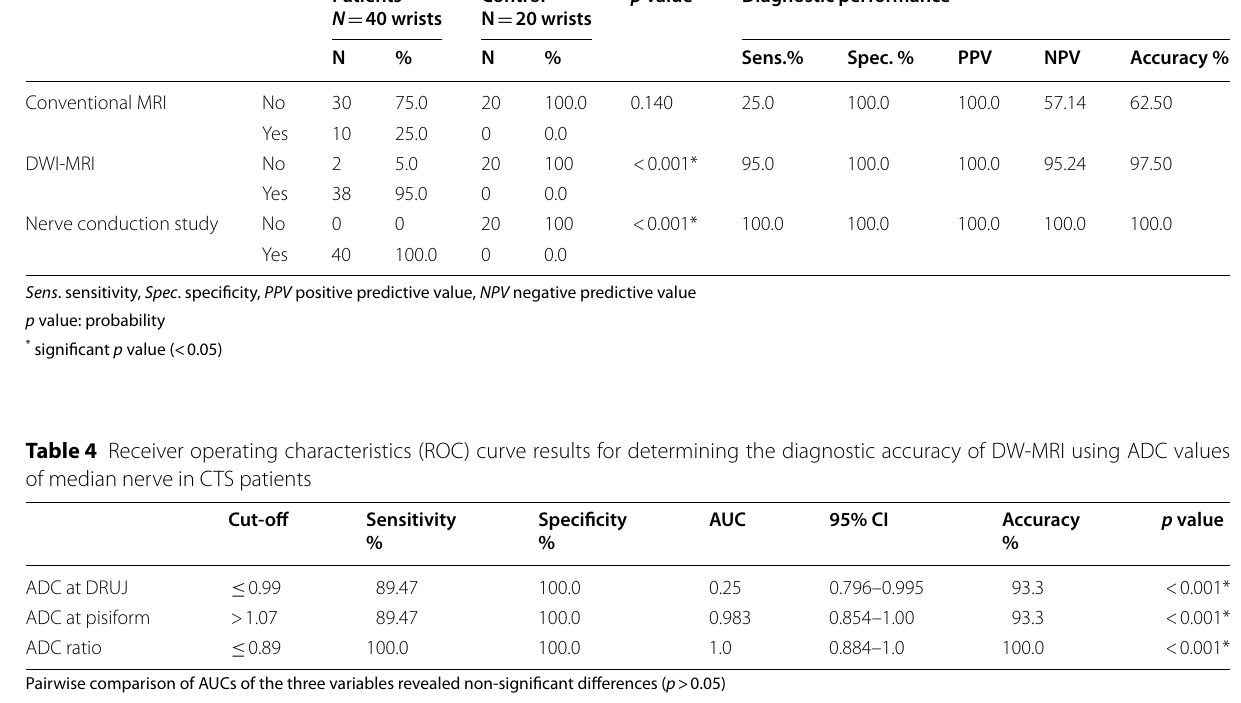
Pairwise comparison of AUCs of the three variables revealed non-significant differences ( p > 0.05) AUC area under the curve, CI confidence interval p value: probability * significant p value (<